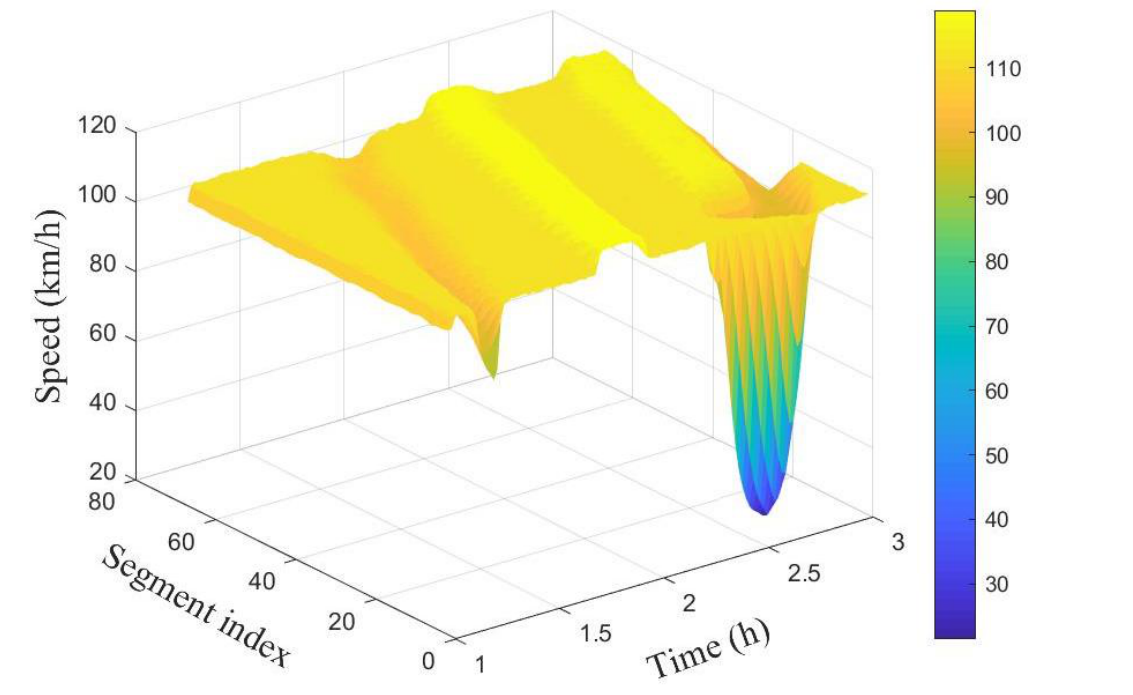
Figure 4. Spatio-temporal evolution of traffic speed for the 100